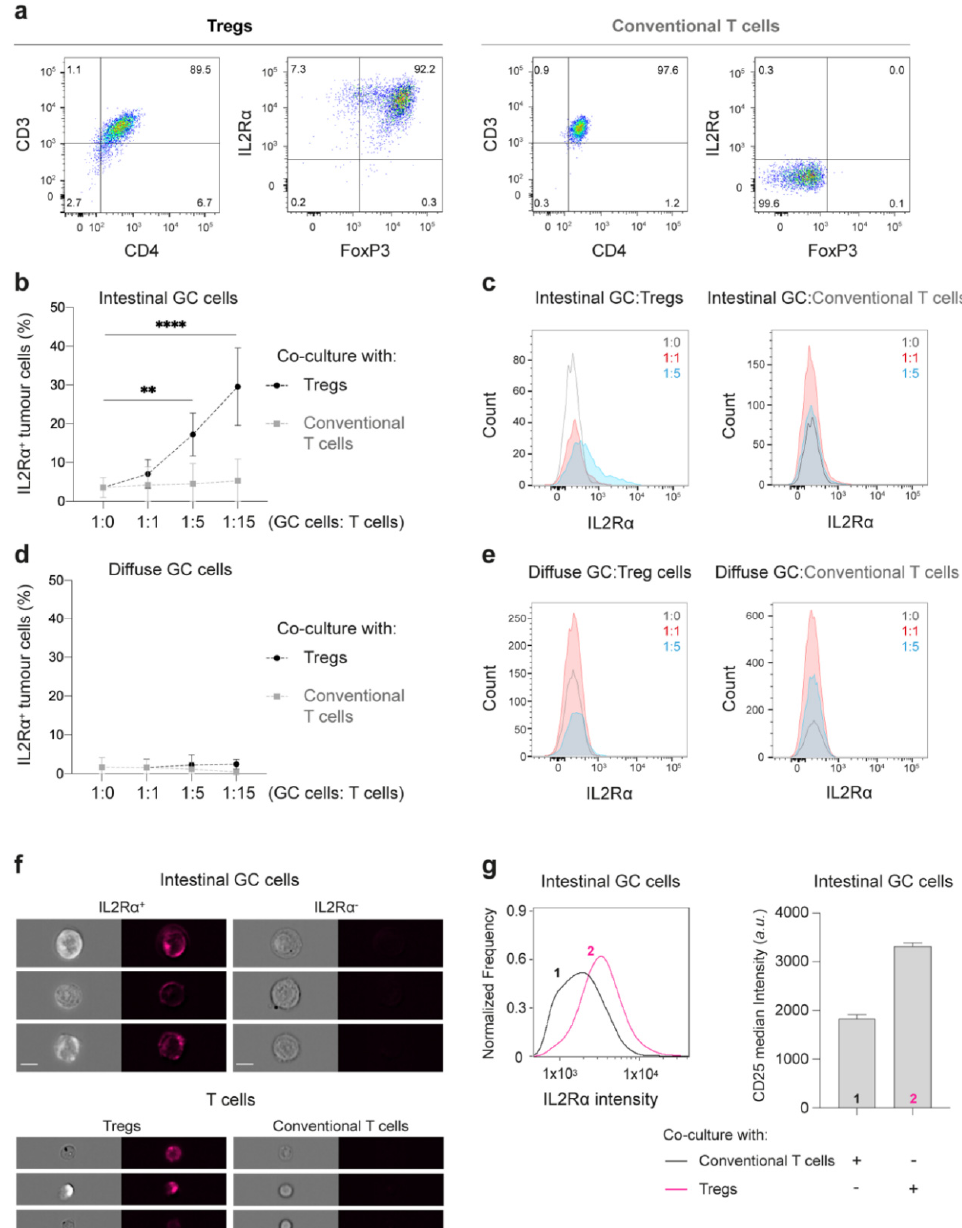
Figure 4. Characterization of GC and T cells after 48 h of co-culture. ( a ) Representative pseudocolor plots with the expression of CD3, CD4, IL2R α , and FoxP3 T cells markers by flow cytometry show that Tregs and conventional T cells maintain their characteristic phenotype after 48 h of co-culture. ( b – e ) Quantitative expression of IL2R α in GC cells. ( b , d ) Plots showing percentage of IL2R α positive intestinal- ( b ) or diffuse-type GC ( d ) cells after 48 h co-culture with Tregs (black) or conventional T cells (grey). Data are shown as mean ± SD for co-cultures treated with T cells isolated from at least six healthy donors. ** p < 0.01, **** p < 0.0001. Two-way ANOVA with Dunnett’s multiple comparisons test. ( c , e ) Representative histograms of IL2R α expression in intestinal- ( c ) or diffuse-type GC ( e ) cells after co-cultured at 1:1 (red) or 1:5 (blue) proportions with T cells. ( f , g ) Detection of membranous IL2R α expression by imaging flow cytometry. ( f ) Representative images of IL2R α expression in IL2R α positive (top left) and negative (top right) intestinal GC cells, as well as in Tregs (bottom left) and conventional T cells (bottom right). Scale bar: 10 μ m. ( g ) Representative histogram of IL2R α expression at the cell membrane (left graph) of intestinal-type GC cells co-cultured with conventional T cells (1-dark line) or Tregs (2-pink line) at 1:5 proportion and after 48 h of co-culture. Quantification of the median IL2R α intensity at the cell membrane (right graph). Graphs represent data from at least three independent experiments.